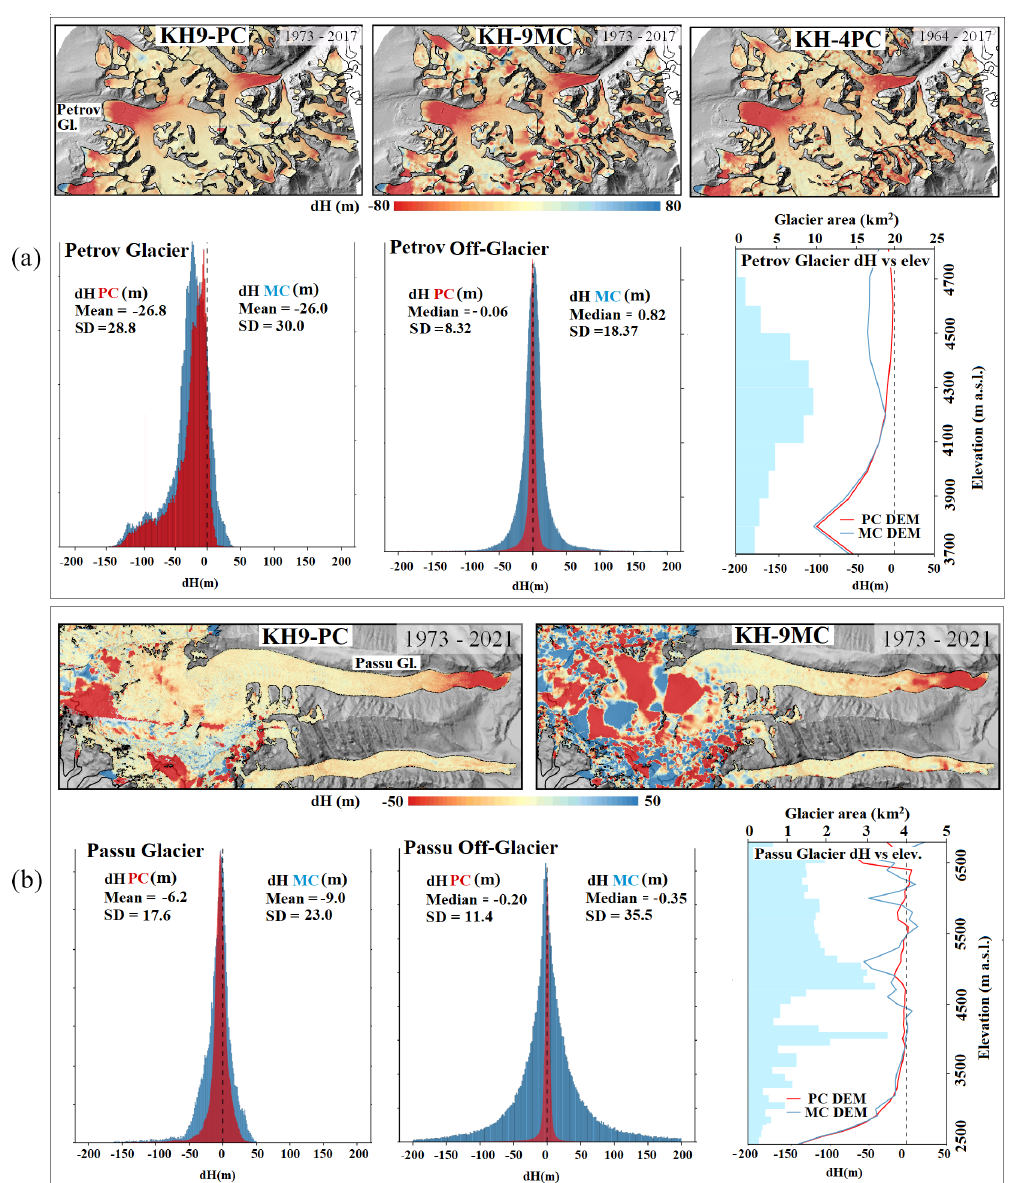
Figure 2. (a) dH of KH-9PC (1973), KH-9MC (1973) and KH-4PC (1964) DEMs with the SPOT-6 (2017) DEM over Ak-Shirak. (b) dH of the KH-9PC (1973) and KH-9MC (1973) DEMs with Pléiades (2021) DEM over Passu Glacier. Bottom graphs: the corresponding dH histograms for glacier and off-glacier pixels and change in dH with respect to the elevation. These dH grids and the corresponding histograms show elevation differences without the filtering and gap filling, which is performed before mass balance computation. The filtered versions of the dH grids are available in Fig. S5. The linear feature visible in the dH image over the accumulation zone of Passu Glacier is due to the boundary of successive images having only a small